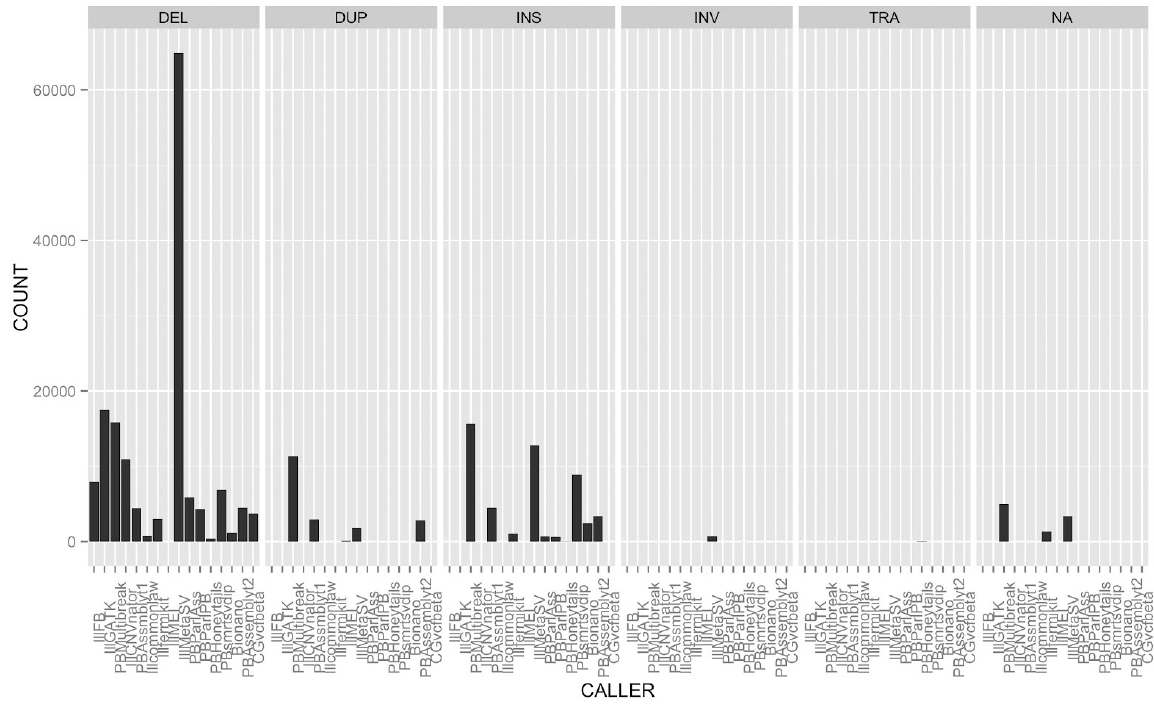
Figure 2. Number of calls per callset for each type of SV, including filtered calls.